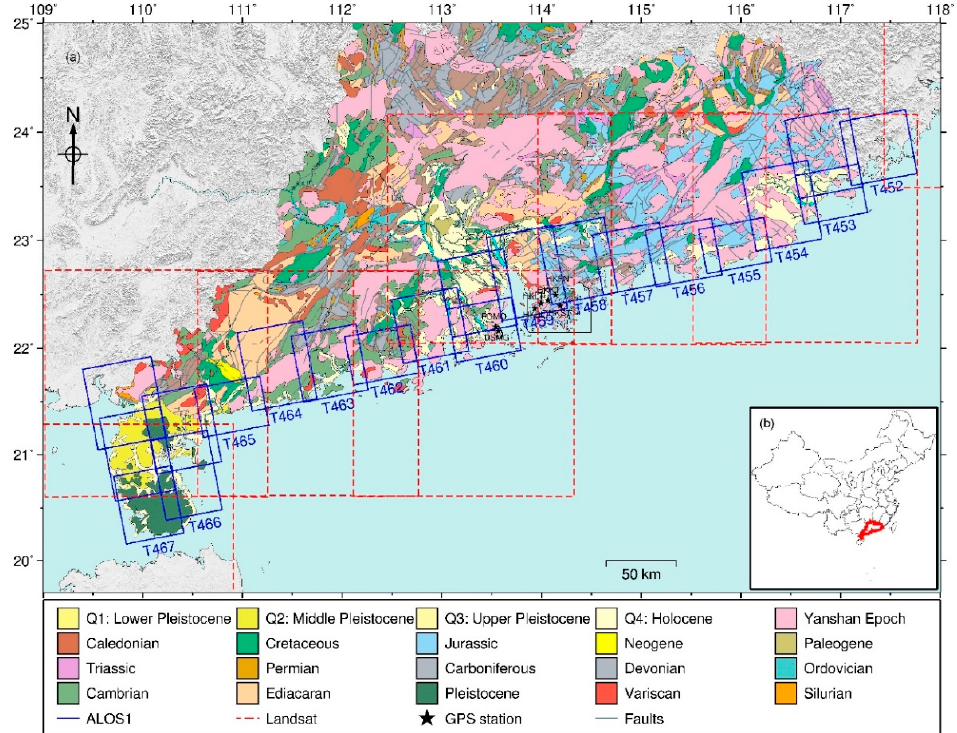
Figure 1. Data coverage and geology formation along the coastline of Guangdong Province. ( a ) Blue solid and red dotted rectangles represent the collected synthetic aperture radar (SAR) images and Landsat optical images, respectively. The black stars represent the GPS stations used, and the gray lines represent faults. ( b ) The location of the study area.